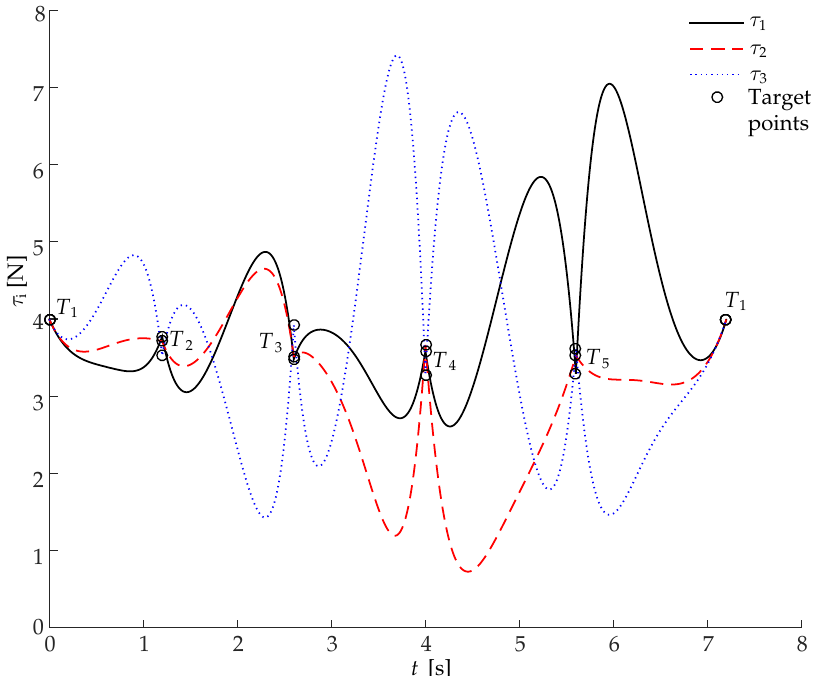
Figure 8. As Figure 7, for the trajectory defined by fifth-order polynomial